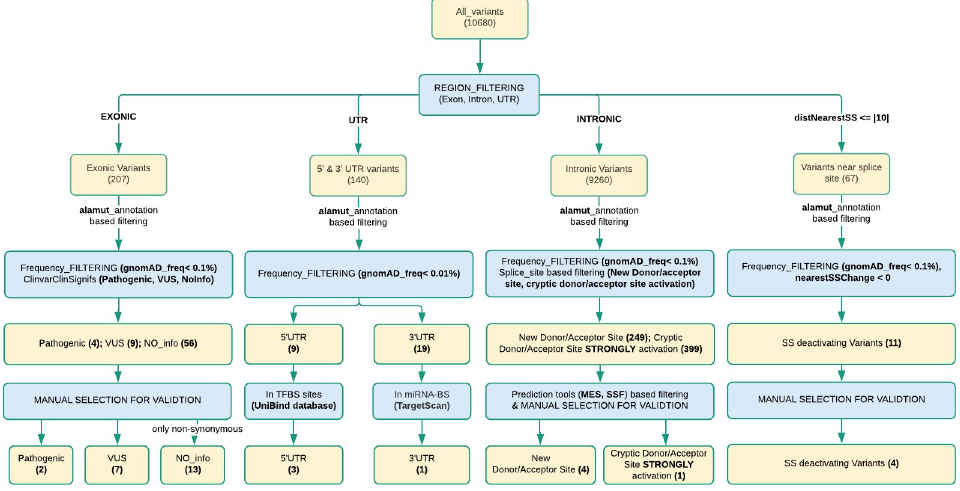
Fig 2. Filtering workflow and number of genetic variants